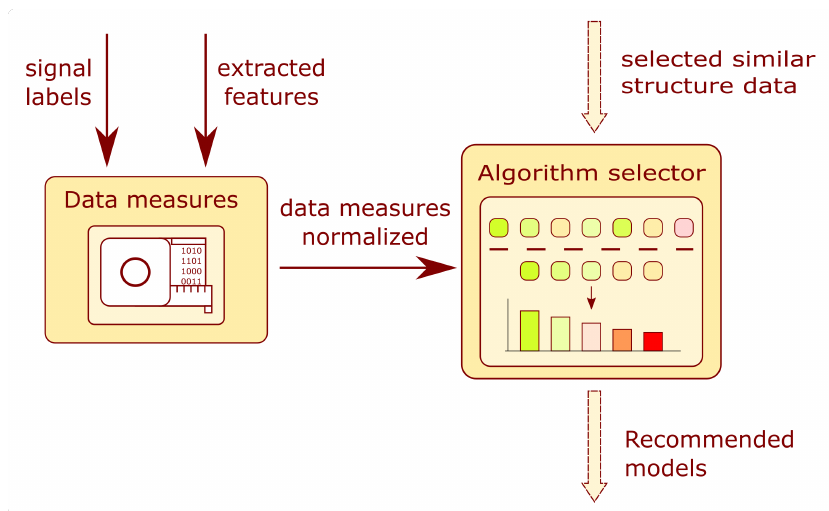
Figure 8. Block diagram of the model selector